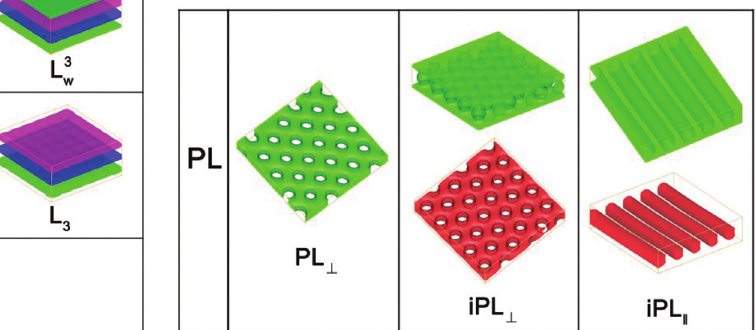
Figure 5: Perforated lamellae. The green and red represents isodensity surface distribution of block A ( f ( f = 2/3) in dendrimer copolymer, B